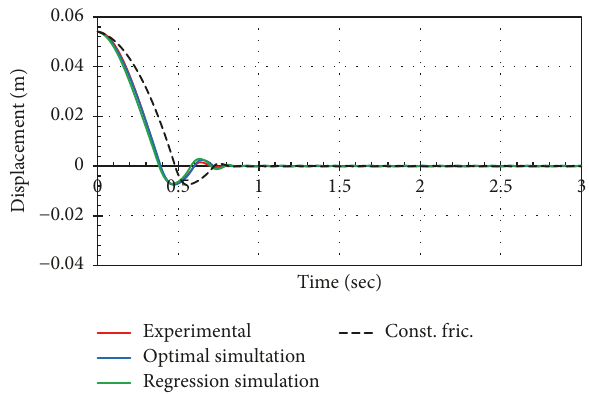
Figure 16: Simulation time history of displacement for the fric- tion function of measuring displacement and individual best fit and overall best fitting function (without lubrication with initial displacement of 106.98 mm).